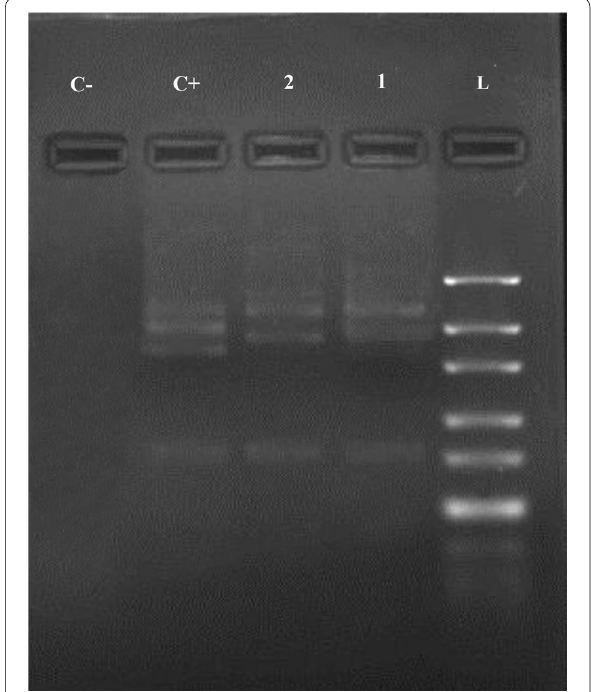
Fig. 2 Agarose gel electrophoresis of ITS1-PCR products of E. granulosus isolates from sheep after digestion with the restriction enzyme Bsh1236I. (lane C negative control, C positive control, − + lane 1 and 2 positive samples, L ladder 50 bp)